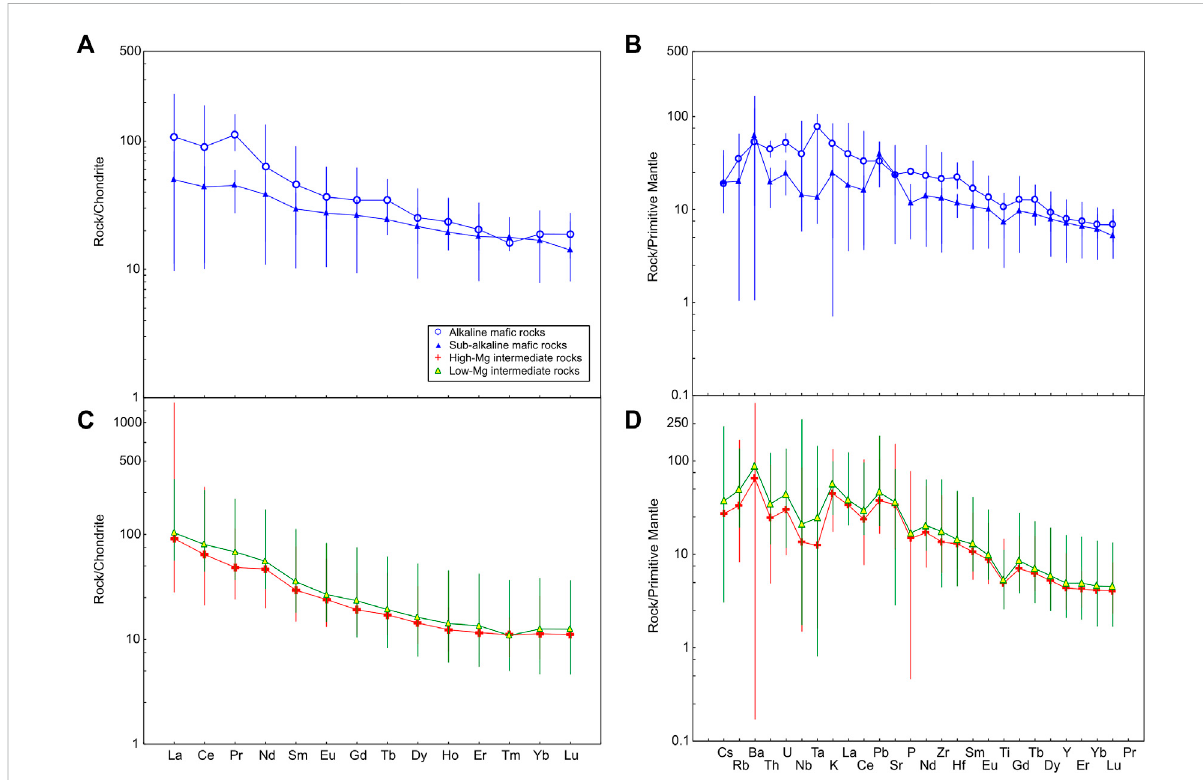
FIGURE 4 (A,B) Chondrite-normalized rare earth element (REE) and primitive mantle – normalized multielement diagram for ma fi c magmas from MGVF. ( C,D) Chondrite-normalizedrareearthelement(REE)andprimitivemantle – normalizedmultielementdiagramforintermediatemagmasfromMGVF. The chondrite and primitive mantle values from normalization are taken from McDonough and Sun